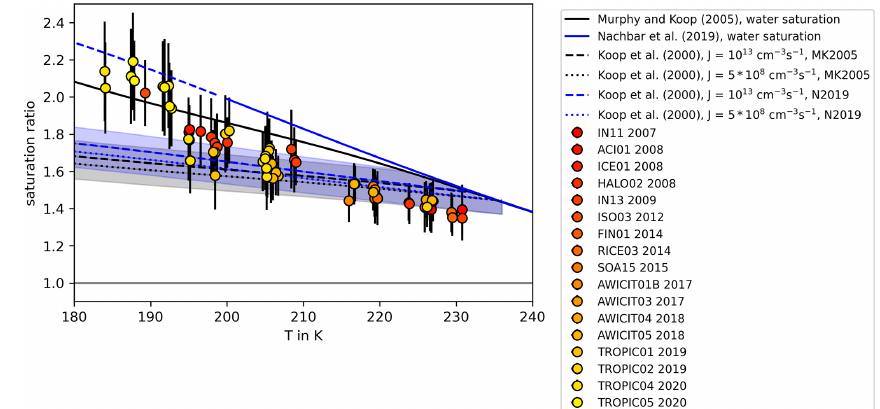
Figure 4. Homogeneous freezing onsets of H 2 SO 4 / H 2 O aerosol particles. The freezing onset conditions, T ice and S ice , fr , are displayed in comparison with the homogeneous freezing thresholds suggested by the WAC-based predictions by Koop et al. (2000) (dashed and dotted lines) using two different parameterizations for the water saturation pressure with respect to supercooled liquid water from Murphy and Koop (2005) (MK2005, black) and Nachbar et al. (2019) (N2019, blue). The blue and grey shaded areas indicate the uncertainties of the WAC-based predictions ( ± 5% in water activity) as given in Koop (2004). The used water saturation pressures with respect to supercooled liquid water according to MK2005 (solid black line) and N2019 (solid blue line) are also shown. The colors of the measurement data points represent the different AIDA campaigns in the corresponding years. The oldest campaigns are presented in reddish colors, whereas the more recent campaigns are shown in yellowish